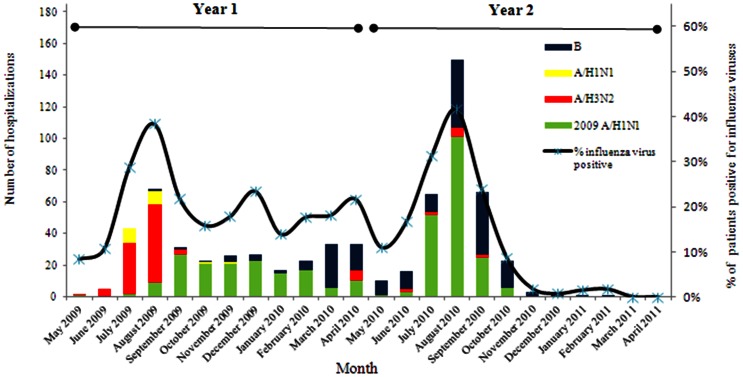
Laboratory confirmed influenza-associated hospitalizations by month of disease onset and influenza type/sub-type, Vadu, District Pune, India, May 2009–April 2011 (n = 665).